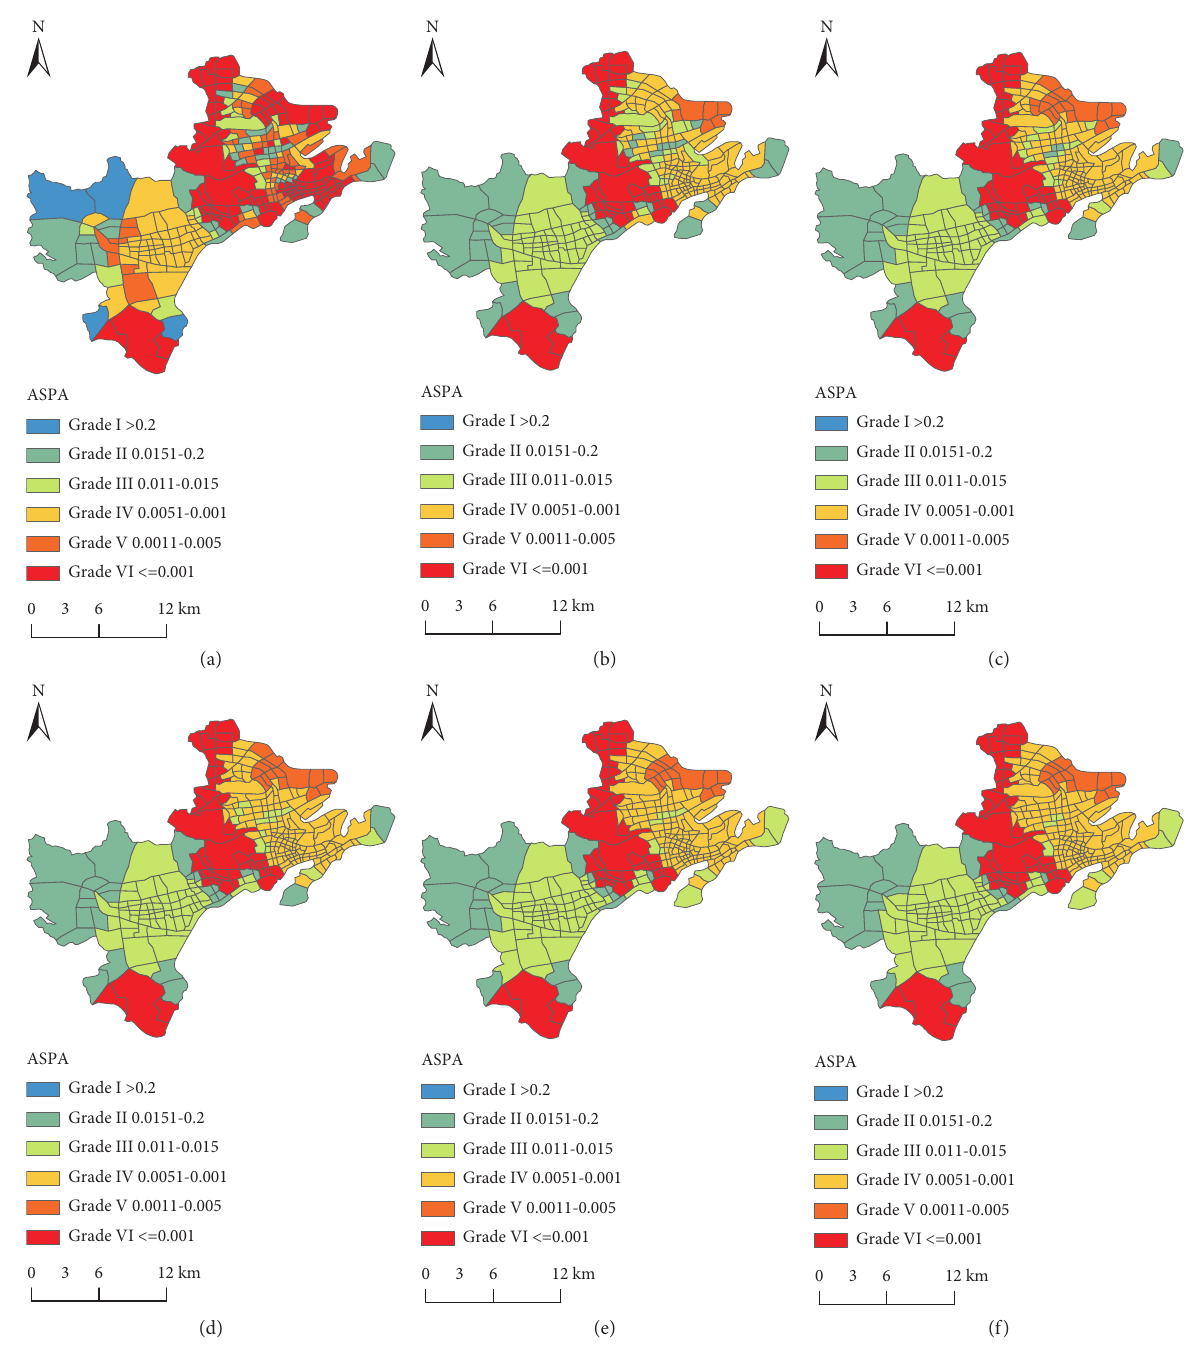
Figure 8: The geographic patterns of adjusted spatial access (ASPA) with different impedance coefficients. (a) β � 10. (b) β � 25. (c) β � 40. (d) β � 55. (e) β � 70. (f) β �